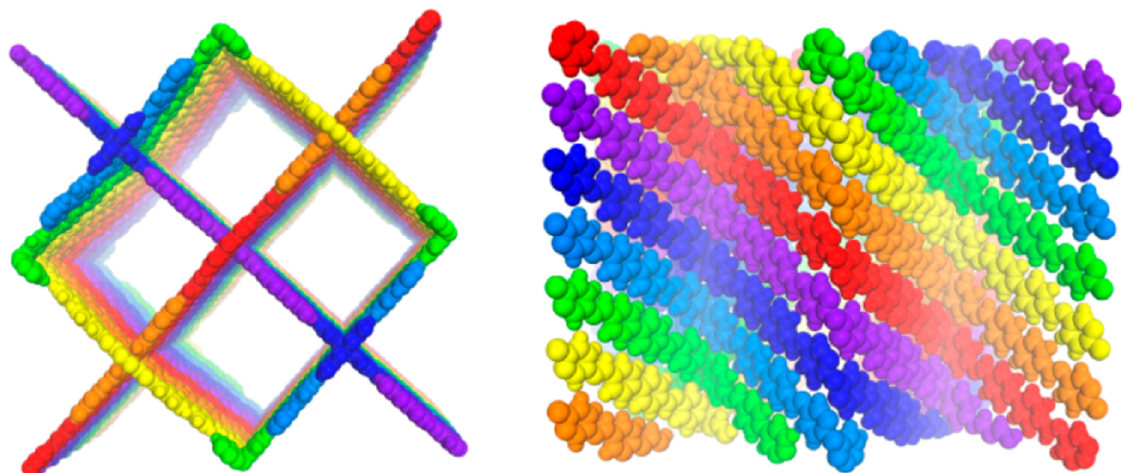
Figure 16. The structure of SP-3D-COF-1. Reprinted (adapted) with permission from [56]. Copyright 2018 American Chemical Society.